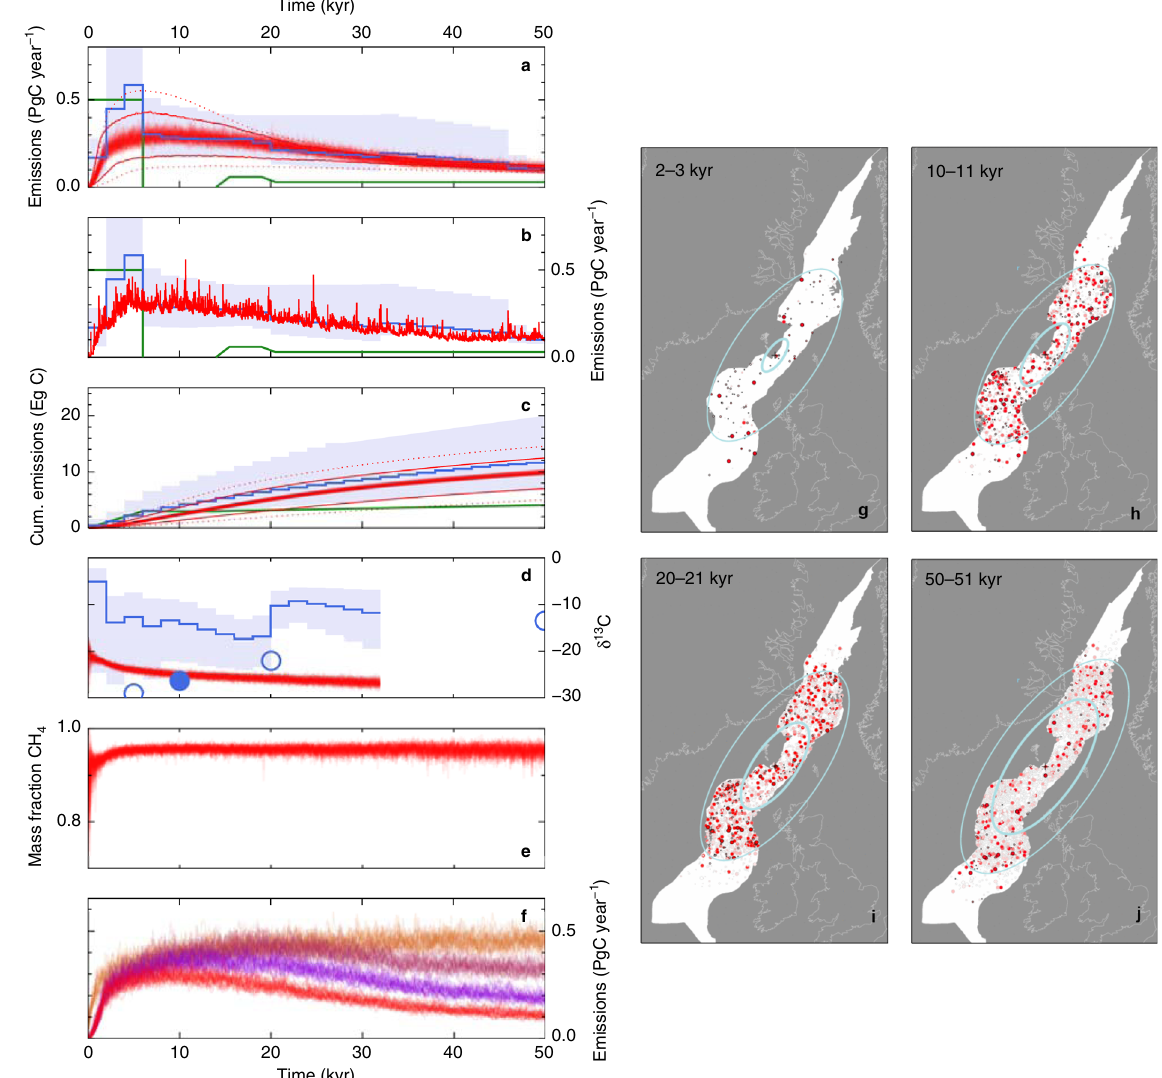
Fig. 8 NAIP carbon emissions based on mantle convection model, and comparison with climate-based emissions reconstructions. a The red cloud is a stack of 100 simulated NAIP emissions fl ux histories with variable τ repeat controlled by plume head model and NAIP geography and the median mantle plume fl ux estimate. Red lines show ensemble means using the upper and lower quartile mantle plume fl ux estimates; dotted red lines show ensemble means using the 10th and 90th percentile plume fl ux estimates. The blue line and envelope show the emissions estimate and uncertainty range from joint inverse modelling of oceanic pH and carbon isotope records 5 . The green line shows emissions estimated from forward modelling of carbon isotope and deep-sea carbonate dissolution records 6,13 . b Emissions fl ux for one stochastic run. c Cumulative emissions associated with a. d Isotopic composition of emissions. Blue circles are sensitivity experiments that show impact of uncertainty in PETM onset duration on mean isotopic composition of emissions 5 ; fi lled circle most closely comparable with our simulations (10 kyr onset). Blue line/envelope truncated at 30 kyr, when signi fi cant carbon burial begins to in fl uence predicted composition of emissions 5 . e Proportion of total emissions released as thermogenic methane. f Exploration of mechanisms for post-peak reduction in emissions itemised in Fig. 7: red stack, same as a ; purple stack, ignoring effect of overlapping sill aureoles; maroon stack, ignoring effects of overlapping aureoles and radial decrease in sill intrusion density; brown stack, constant τ repeat = 4 yr, i.e. ignoring effects of overlapping aureoles, radial decrease in sill intrusion density and radial spreading of magma generation zone. g – j Snapshots from one NAIP simulation (Supplementary Movie 1) showing sills intruding the the Rockall – Faroe-Shetland – Møre-Vøring sedimentary basin chain at progressively increasing distances from province centre. Red circles show sill – vent systems currently emitting carbon: the shade of red is proportional to the emissions fl ux and the size is proportional to fi nal cumulative emissions (horizontal scale exaggerated). Older sill – vent systems no longer emitting carbon are coloured grey. Pale blue ellipses show positions of the thermal anomaly in the sub-plate convecting mantle, which generates the sill-province magma: the heavy line marks the peak thermal anomaly; the thin line indicates 5% of the peak thermal We only account here for mantle-derived carbon released from comprising the NAIP magma-rich passive margins is 3.8 × 10 6 km 3 (ref. 29 ), which could release 14,100 PgC of carbon with a shallowly intruded NAIP sill magma, generated by lithospheric mantle-derived isotopic signature. The duration of eruption/ thin-spot melting (Fig. 1). Magma generated within the Europe- emplacement, related to the duration of rifting leading to con- Greenland continental break-up zone released further mantle- tinental breakup, is 1 – 3 Myr (refs. 28,29 ), considerably greater derived carbon. The total volume of lavas and deep intrusions